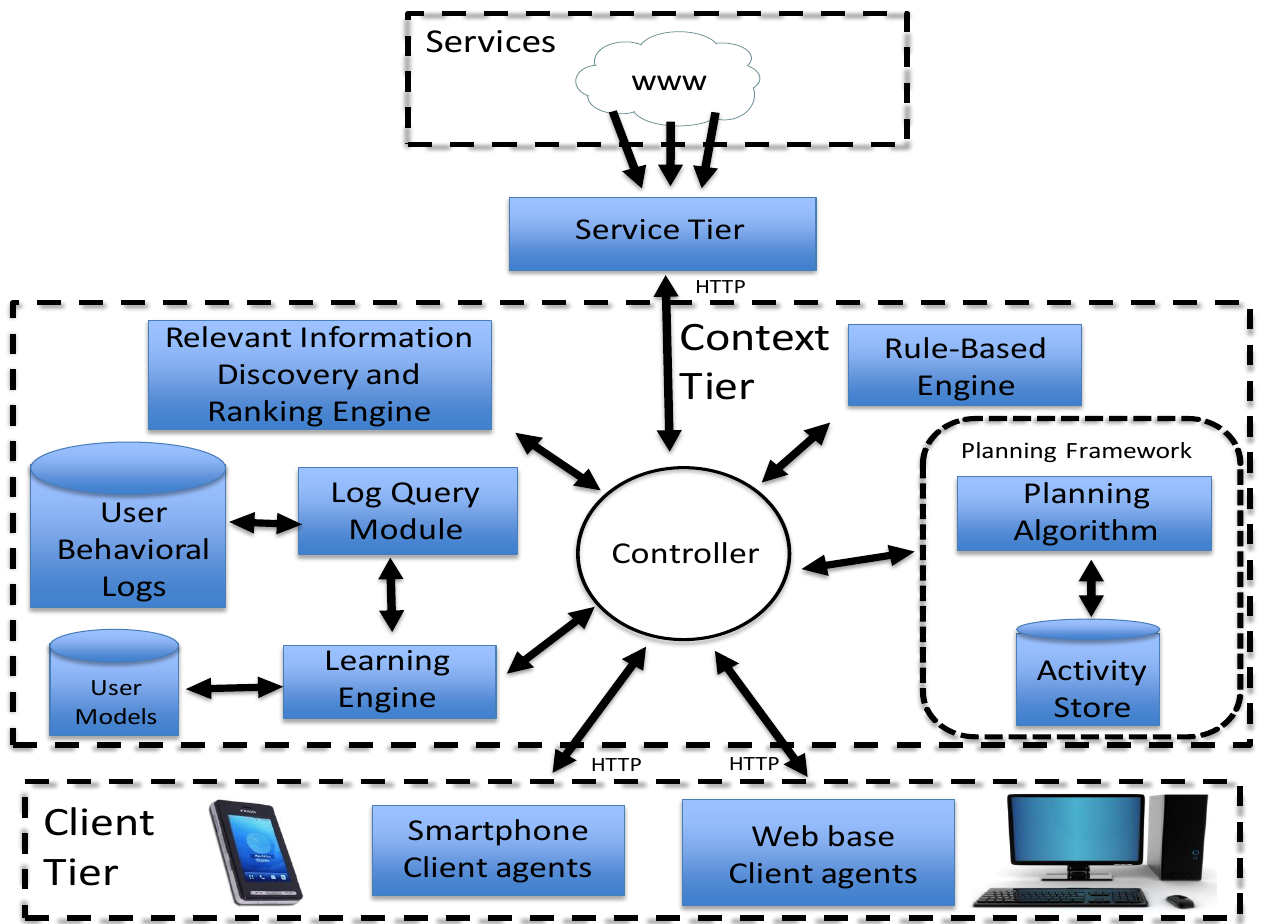
Figure 1: Architecture of the Rover II context-aware